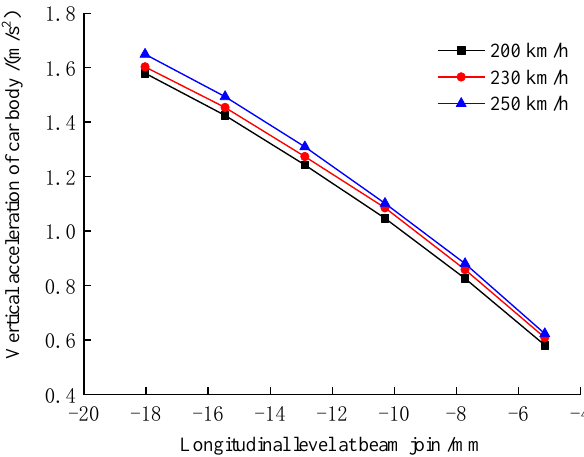
Time (s) Figure 16. Time history curve of wheel – rail vertical force. 2 Time (s) Figure 17. Time history curve of rate of wheel load reduction.